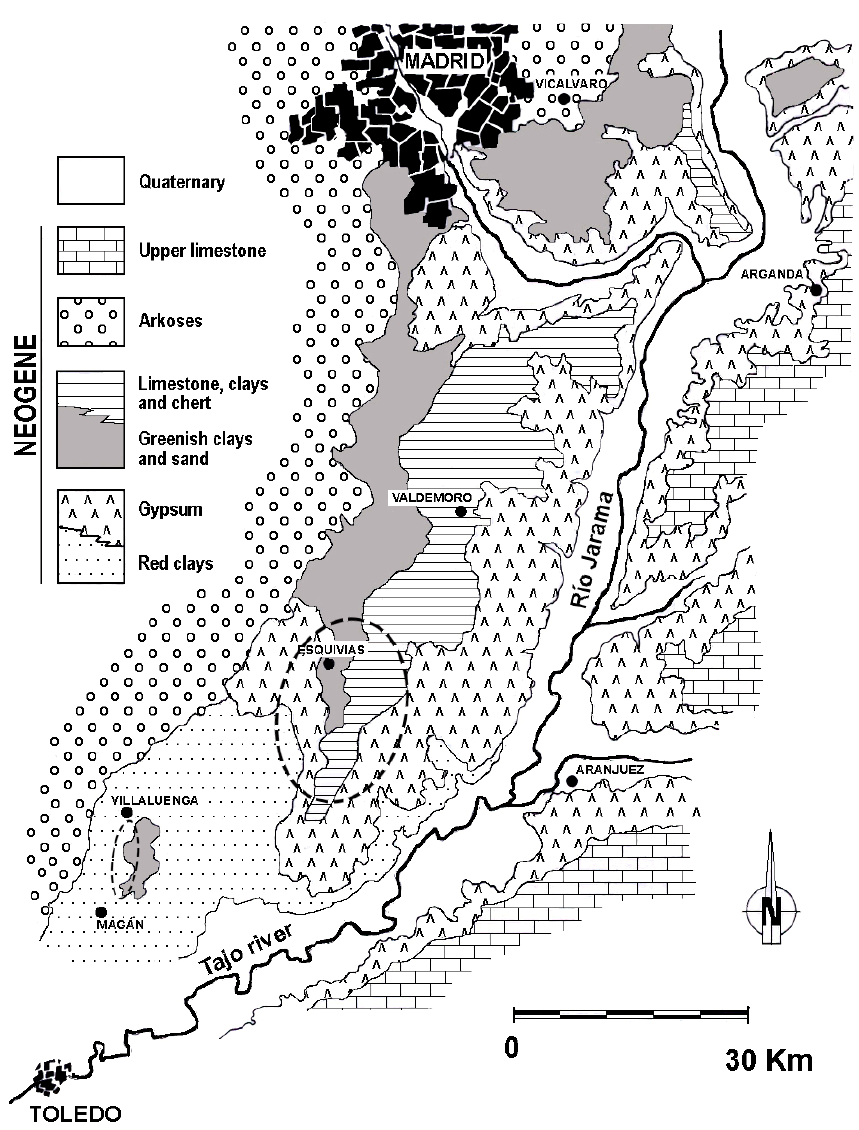
Figure 3. Geological map of the Madrid Basin. The figure corresponds to the square in Figure 1. Studied areas: dotted ellipses. Modified from Reference [72].